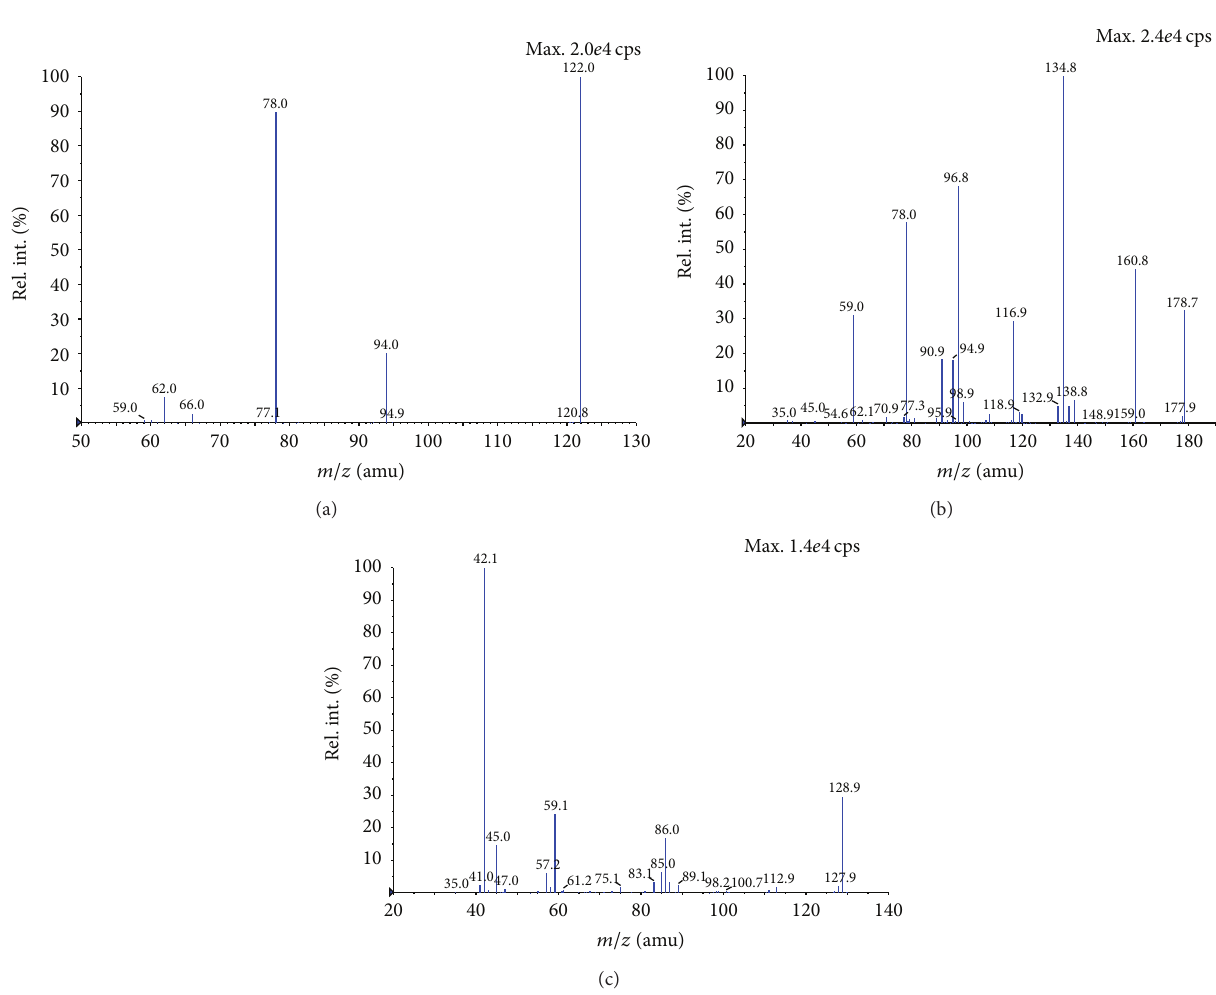
Figure 1: Product ion mass spectra of the deprotonated molecules of NA (a), NUA (b), and 5-FU